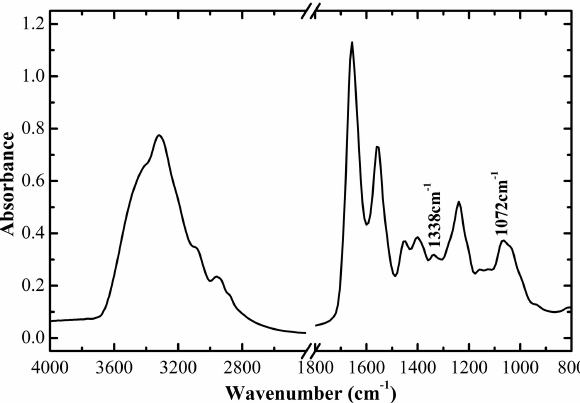
Fig. 1. IR spectrum extracted from FTIR image of a cartilage